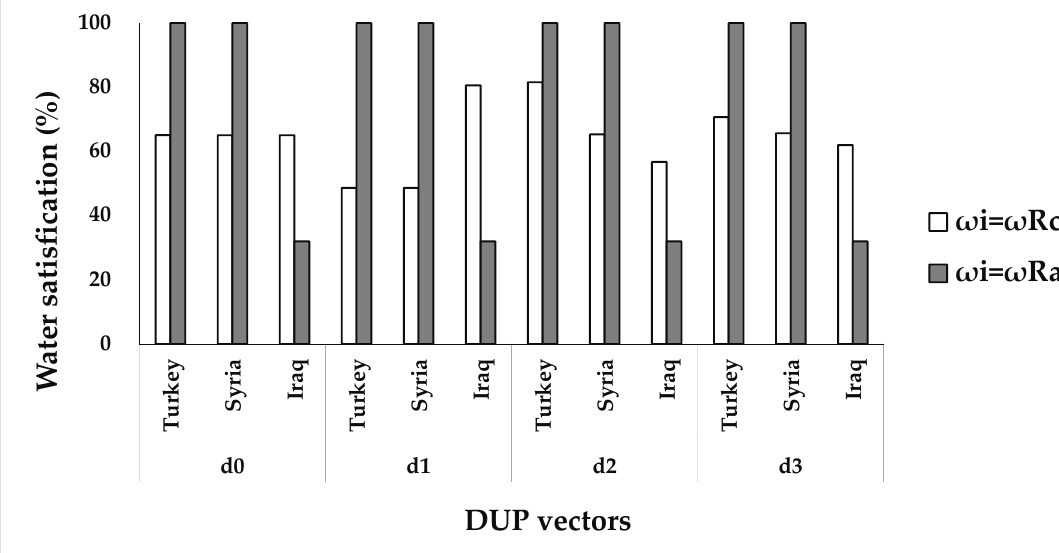
Figure 3. Water satisfactions (%) of three agents under two Nash bargaining solutions with considering different DUP vectors and two bargaining weights of ω Rc and ω Ra . d0 indicates that the agents’ DUP vector is 0; d1 indicates that the agents’ DUP vector is determined by MTBT; d2 indicates that the agents’ DUP vector is determined by MRDC; d3 indicates that the agents’ DUP vector is determined by MENP.